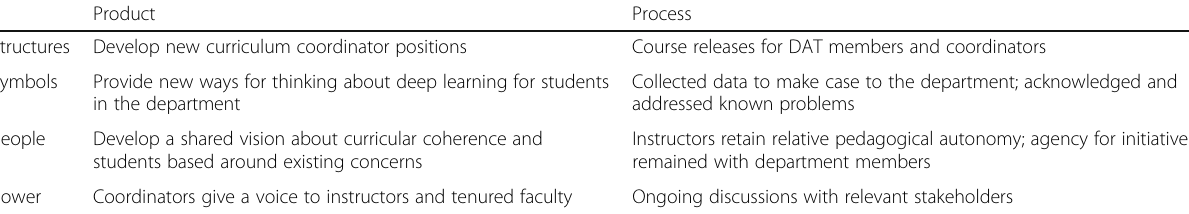
Table 2 Product and process of change in the Runes